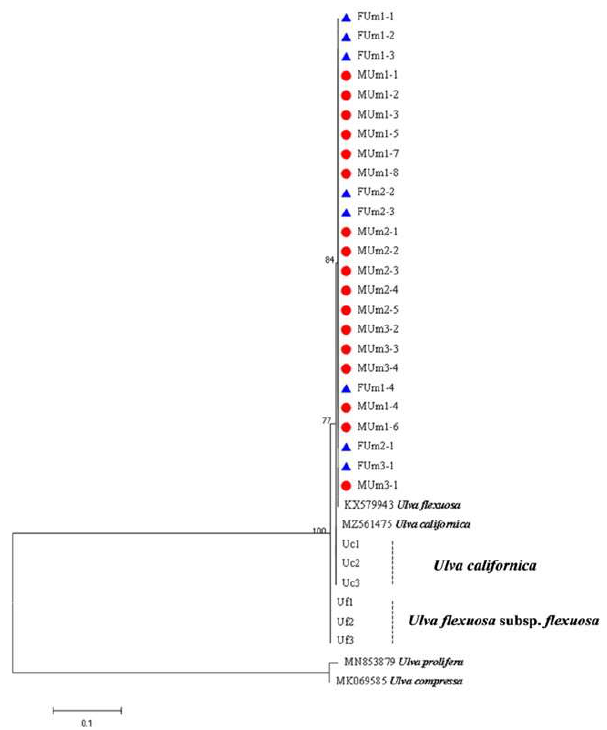
Figure 8. Maximum likelihood tree constructed from the analysis of psb A gene sequences of U. aragoensis samples and those downloaded from GenBank.